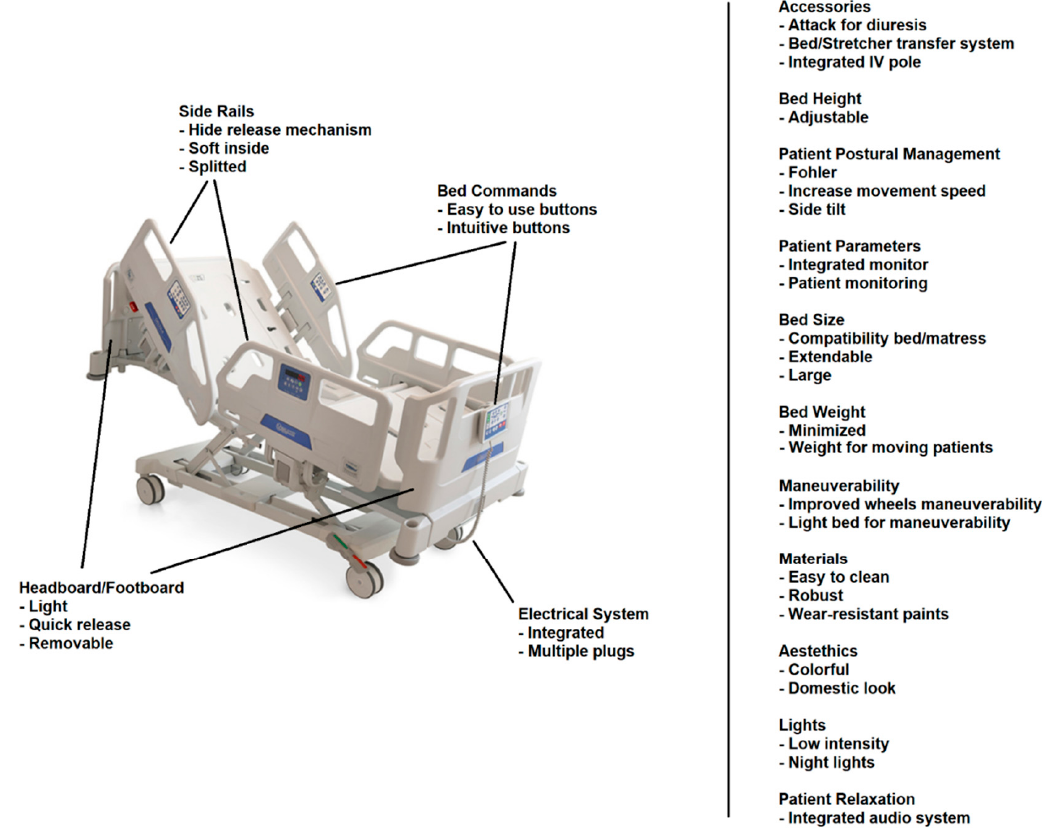
Figure 18. Graphical summary of the results of the study.